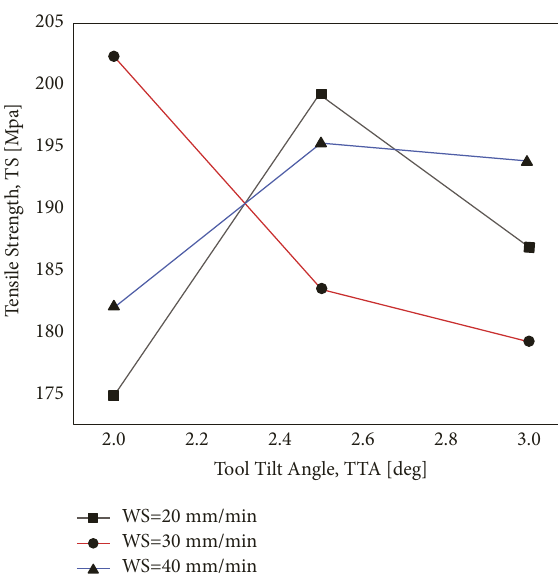
Figure 8: Influence of TRS -1400rpm on TS.